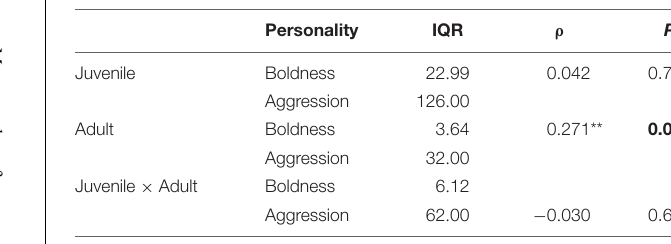
TABLE 2 | Correlation and dispersion between the boldness and aggressiveness of juvenile and adult